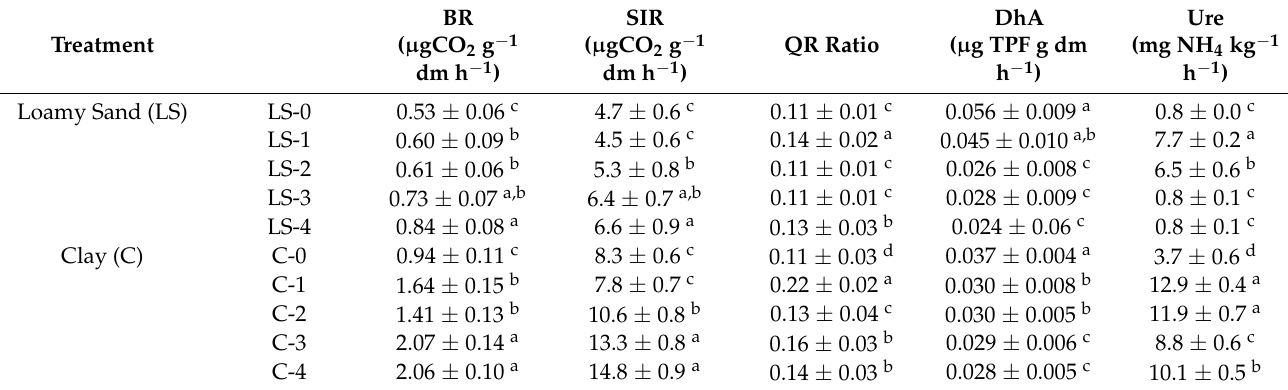
Table 6. Biochemical indicators of the soil after the application of CHAR-C ( ± standard deviation).